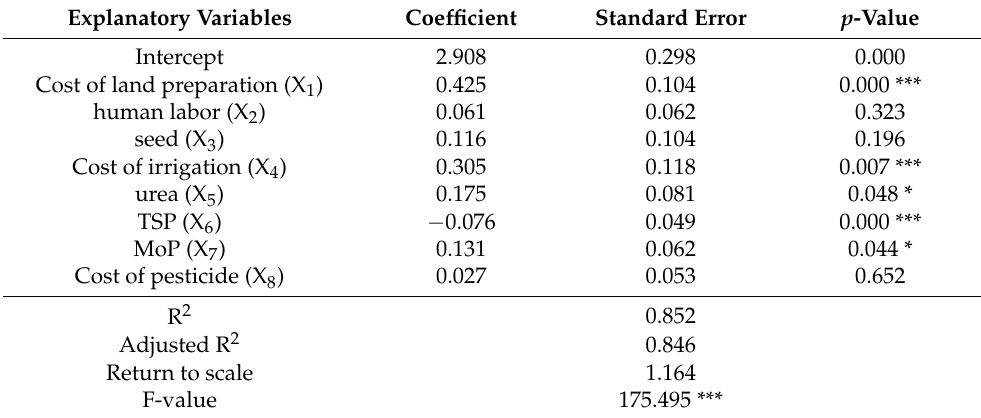
Table 5. Estimated values of coefficients and related statistics of Cobb–Douglas production